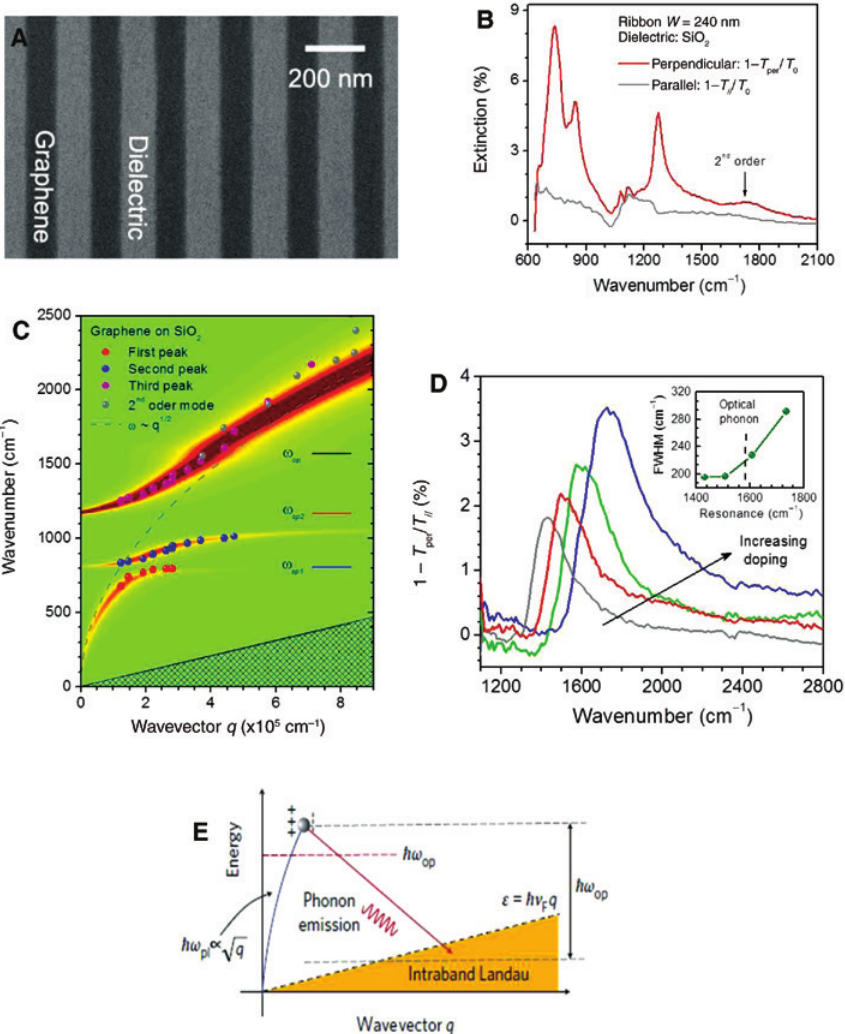
Figure 3: Mid-IR localized plasmons in